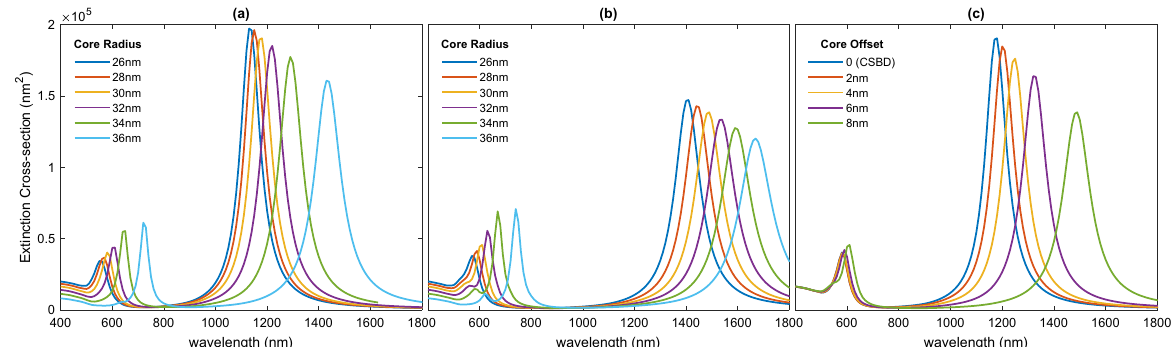
Figure 8. Effect of core size on extinction spectra of ( a ) CSBDs and ( b ) NEBDs. ( c ) Effect of core offset on extiction spectra of